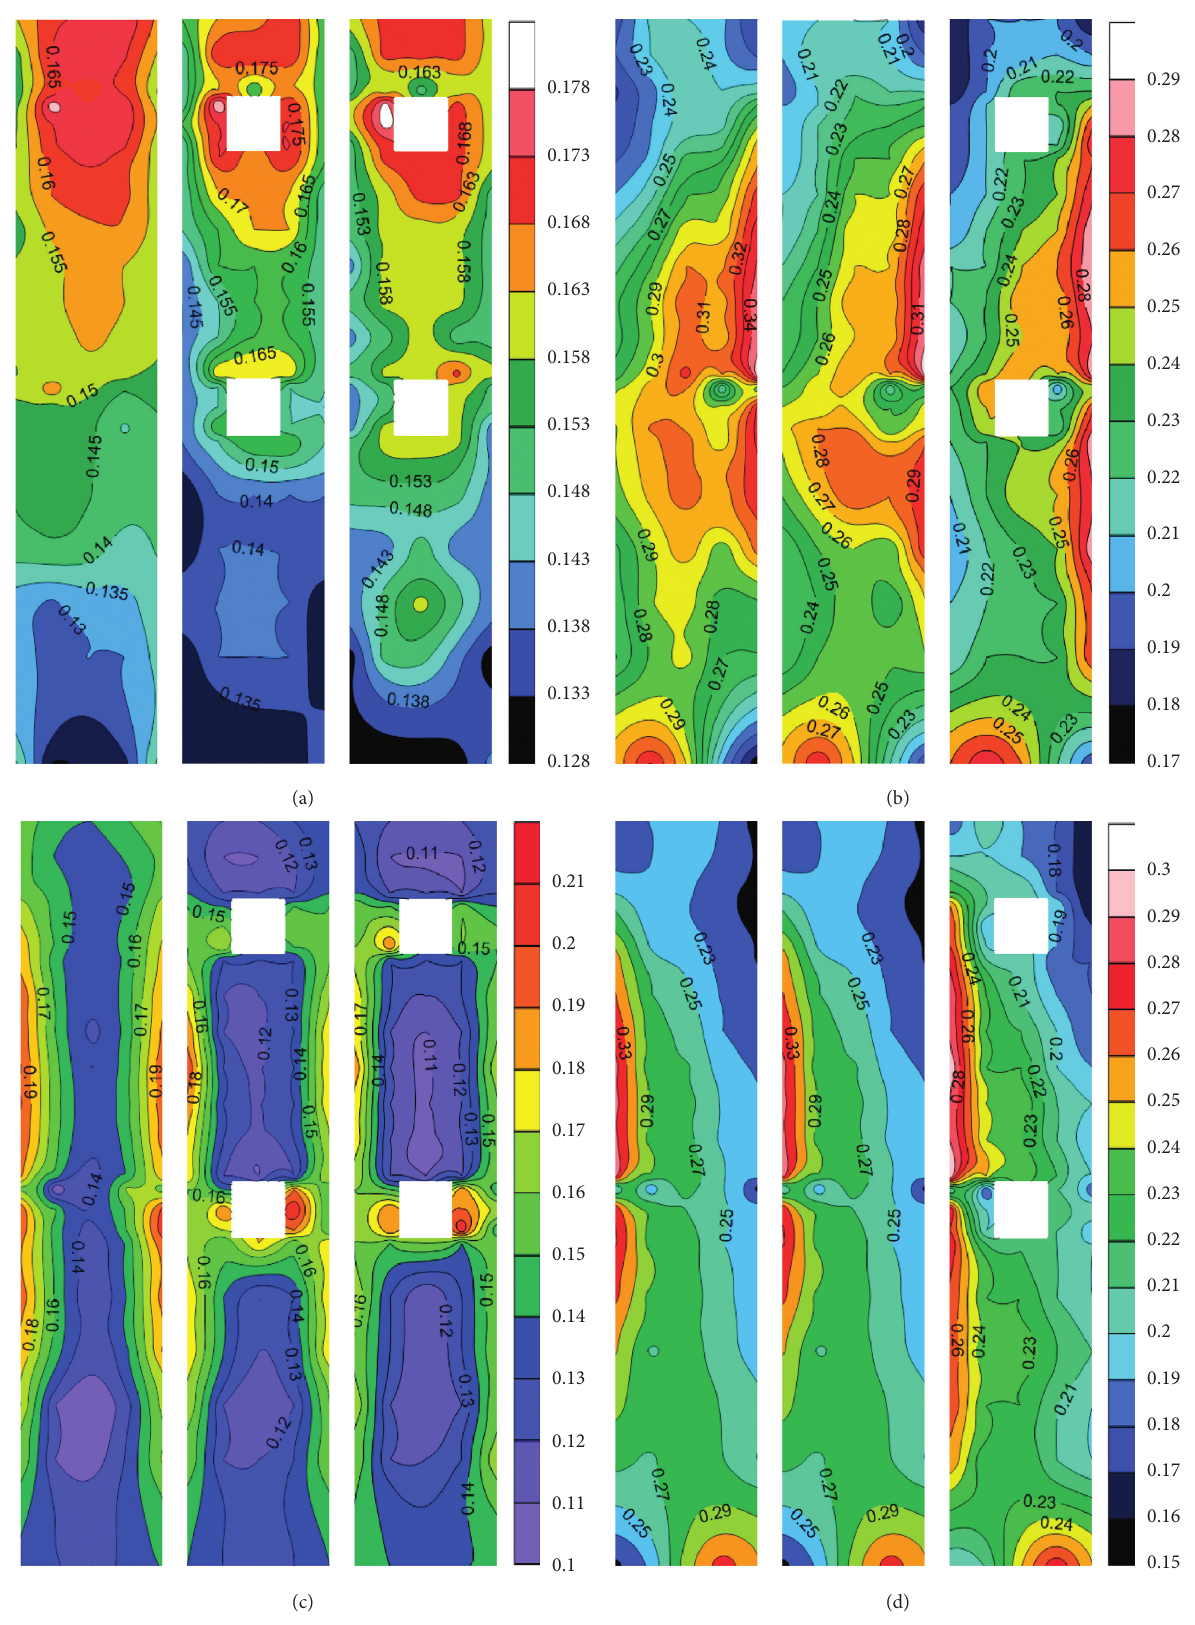
Figure 15: Distribution of fluctuating wind pressure coefficients on the façade under the wind direction of 0 ° . (a) Windward surface (from left to right, L-1, L-2, and L-3, the same below). (b) Right-side wind surface. (c) Leeward surface. (d) Left-side wind